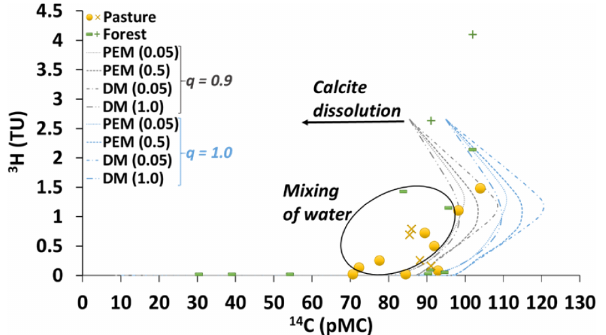
Figure 5. Activities of 3 H (TU) and 14 C (pMC) in the pasture and forest groundwater. PEM represents partial exponential model (PEM ratio in brackets) and DM represents dispersion model (DP parameter in brackets). Cross and plus symbols are for the shal- low riparian groundwater, and other symbols are for the regional groundwater. The single high 3 H activity possibly reflects recharge by winter rainfall. Samples lying to the left of the covariance curves probably record mixing between younger and older groundwater (see text for